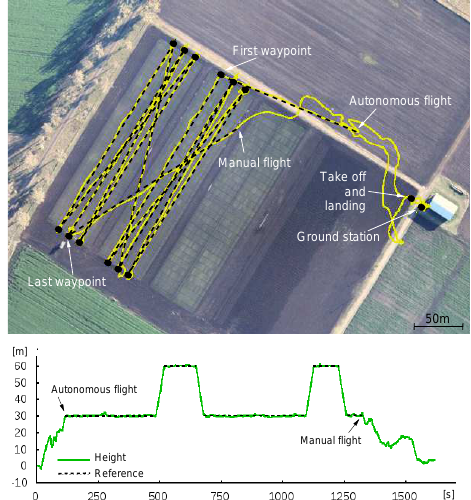
Figure 7: Flight path and height of a typical plant phenomics mission.